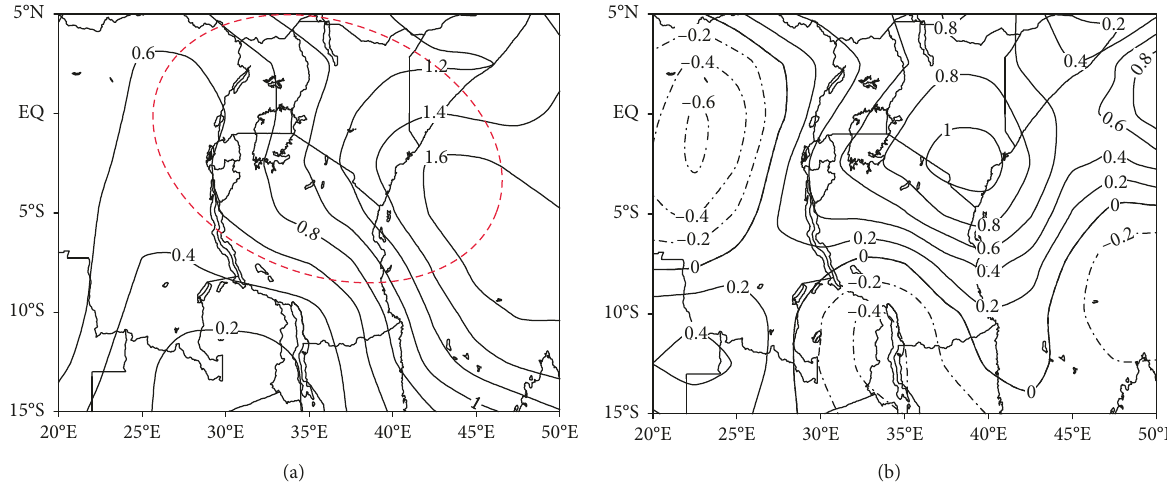
1 and (b) horizontal wind divergence anomaly fields −